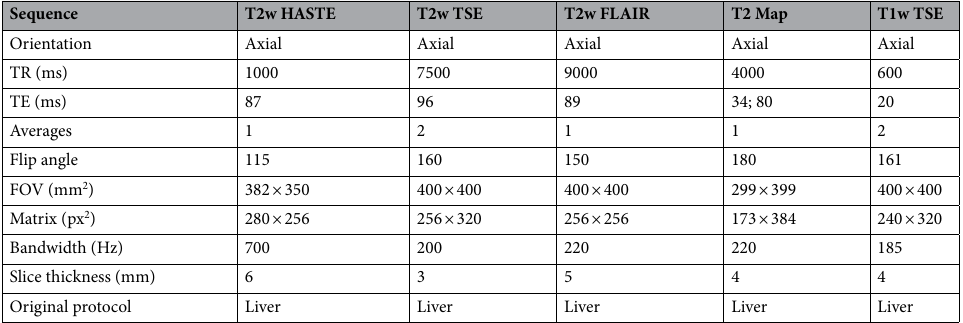
Table 4. Magnetic resonance imaging sequence parameters. Acquisition parameters of the modified clinical routine protocols are shown. FLAIR fluid-attenuated inversion recovery, FOV field of view, HASTE